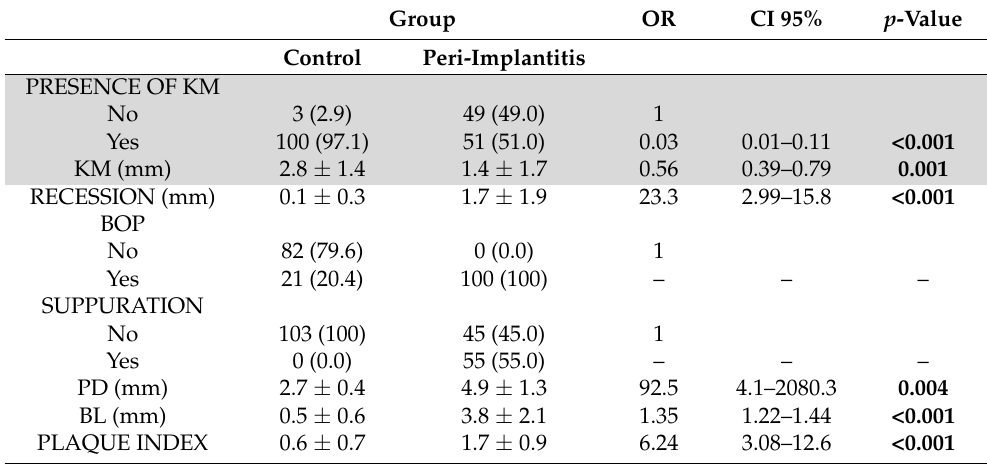
Table 2. Implant clinical and radiographic characteristics and parameters according to diagnostic group (control/peri-implantitis): mean ± sd or n (%). Results of simple logistic regression models using generalized estimating equations (GEE), unadjusted odds ratio (OR) and 95% confidence interval. KM (keratinized mucosa), BOP (bleeding on probing), PD (probing depth), BL (bone level). Group